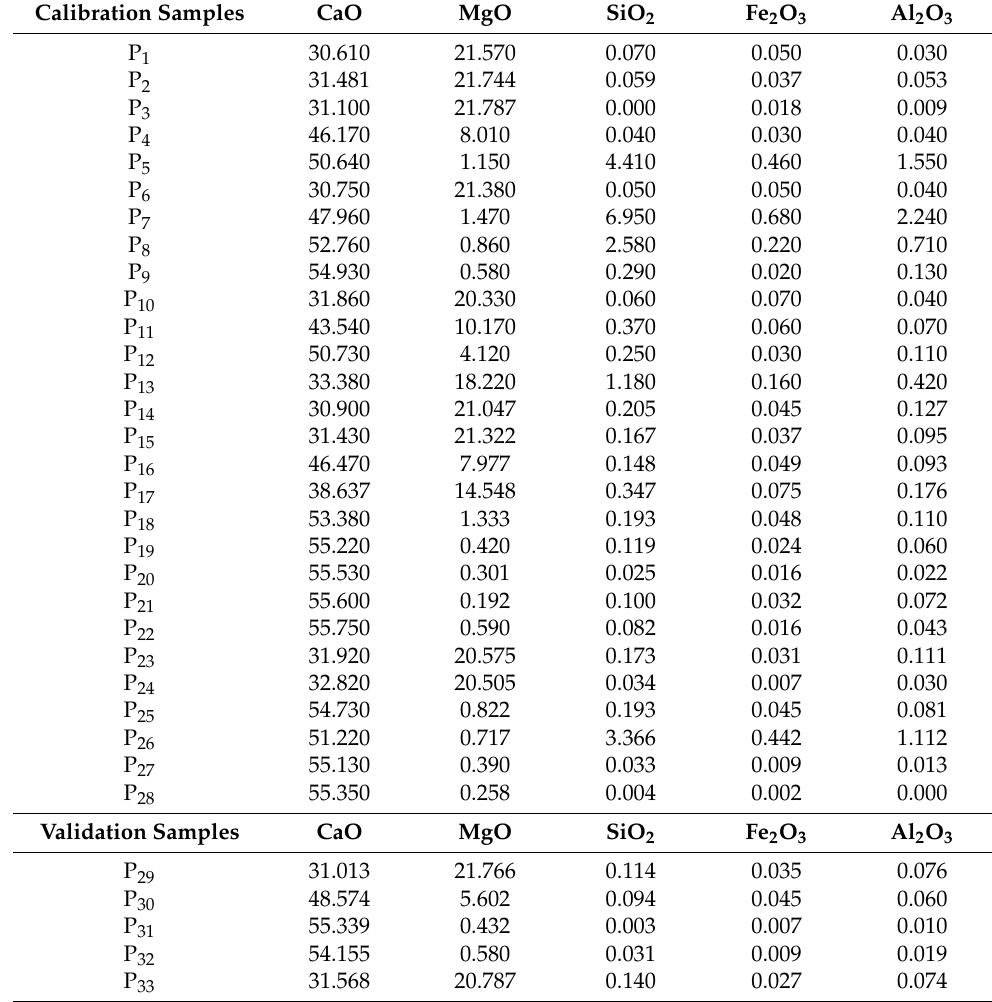
Table 4. Constituent oxides (wt.%) of samples under investigation and of the standard P 1 , as measured using